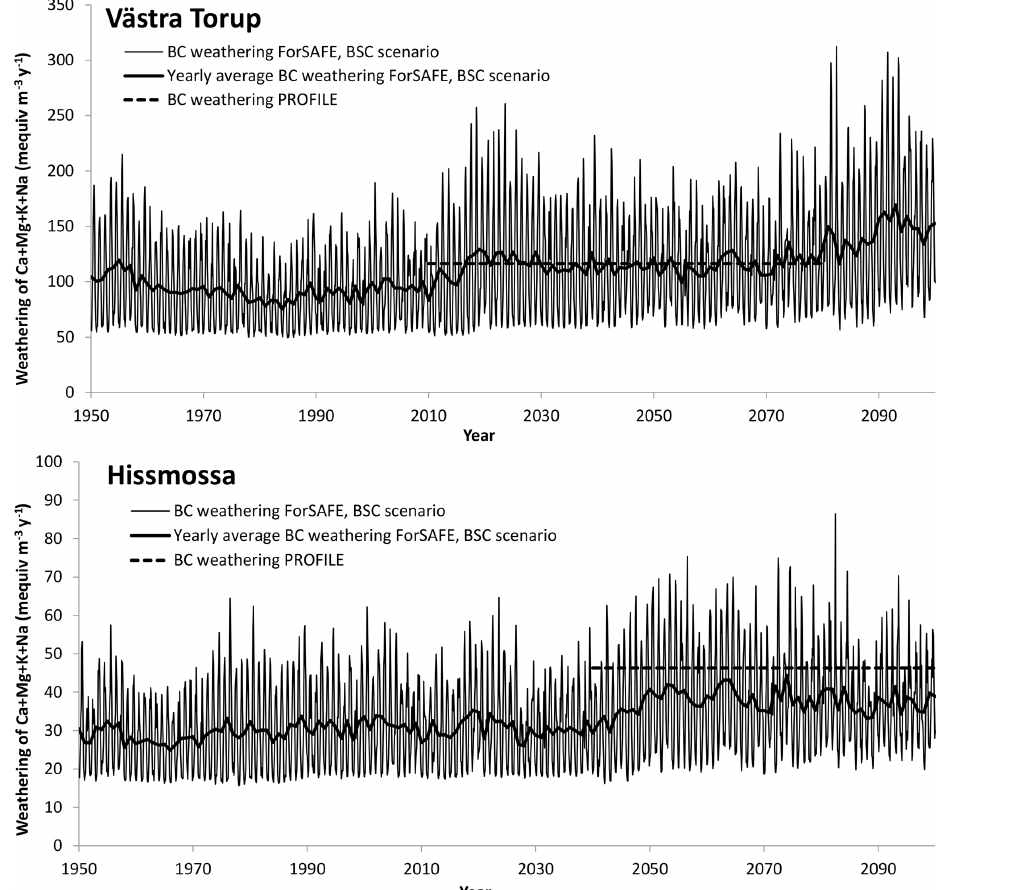
Figure 3. Modelled Ca + Mg + K + Na weathering in Västra Torup and Hissmossa from 1950–2100 (note the difference in scale for the two sites). PROFILE calculates the average weathering rates for the time period represented by the input values, while monthly weathering values were calculated with ForSAFE, using the BSC